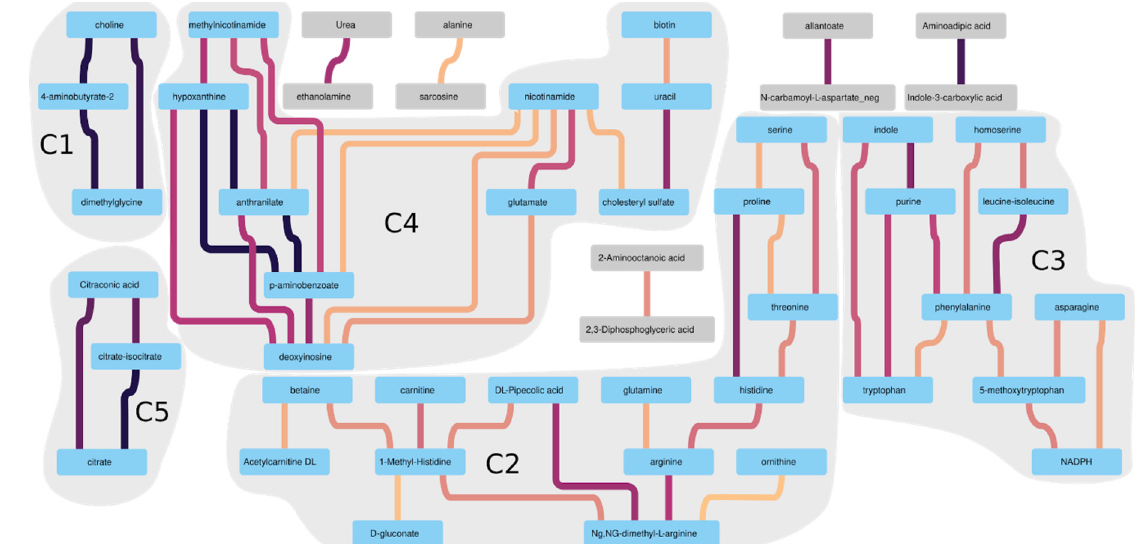
Figure 6. Fragment of the main graph of metabolites pairwise correlation. Only those correlations with correlation coefficients above 95 percentile (R > 0.86) of all correlation coefficients are left. Edge color corresponds to the correlation coefficient (from yellow to black for R ranging from 0.87 to 0.99). Pairs of vertices colored in gray have only a single edge, and vertices colored in blue have more than one edge. The connected components are outlined in gray (entitled C1 to C5).